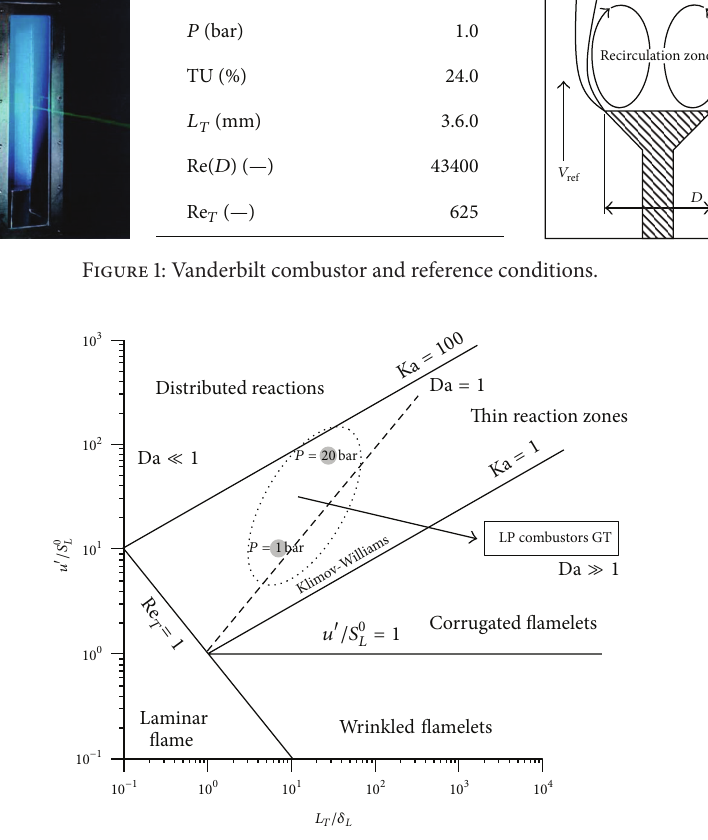
Figure 2: Comparison of turbulent combustion regime of VDB and typical lean premixed gas turbine combustors.